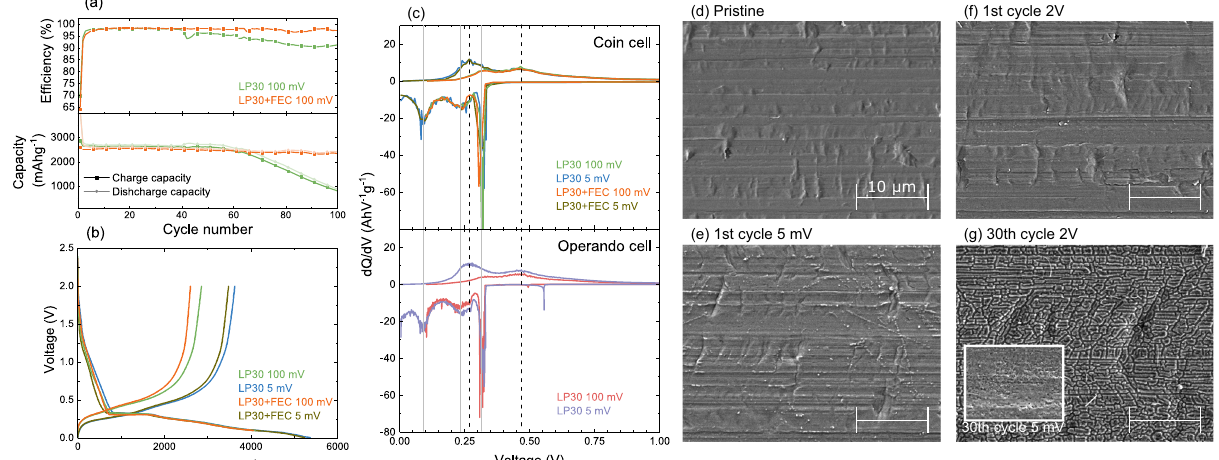
Fig. 1 | Electrochemical and structural characterisation of a-Si electrodes. a Electrochemicalperformanceoftwocoincellswitha-Si(100nm)thin- fi lmanodes on Ni-coated Cu, containing either LP30 or LP30+FEC electrolytes, showing dif- ferences in coulombic ef fi ciency (top) and charge and discharge capacities (bot- tom). b Voltage pro fi les for the fi rst cycle of the coin cells containing LP30 and LP30+FECelectrolytescycled to100mVand 5mV. c Differentialcapacityplot(dQ/ dV) for the fi rst cycle of the coin cells containing LP30 and LP30+FEC electrolytes cycledto100mVand5mV(top),andof operando cellscontainingLP30electrolyte